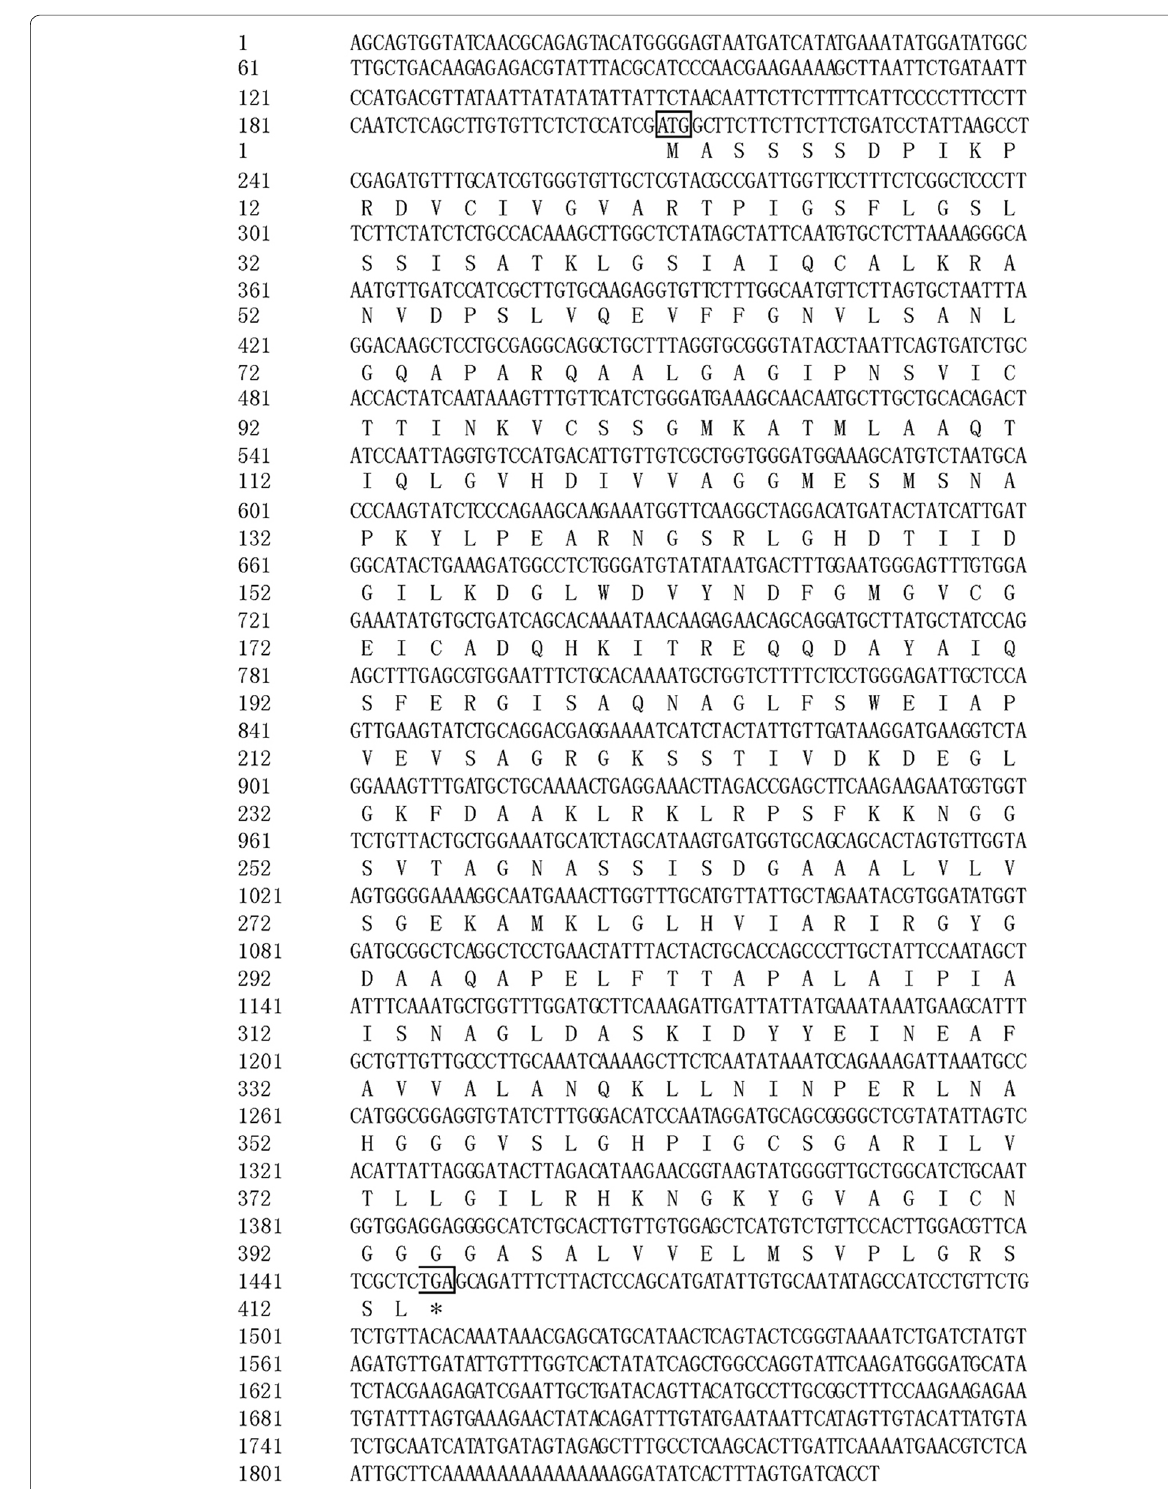
Fig. 1 The full-length cDNA sequence of EhAACT and deduced amino acid sequence. “ATG” is initiation codon, “TGA” is termination